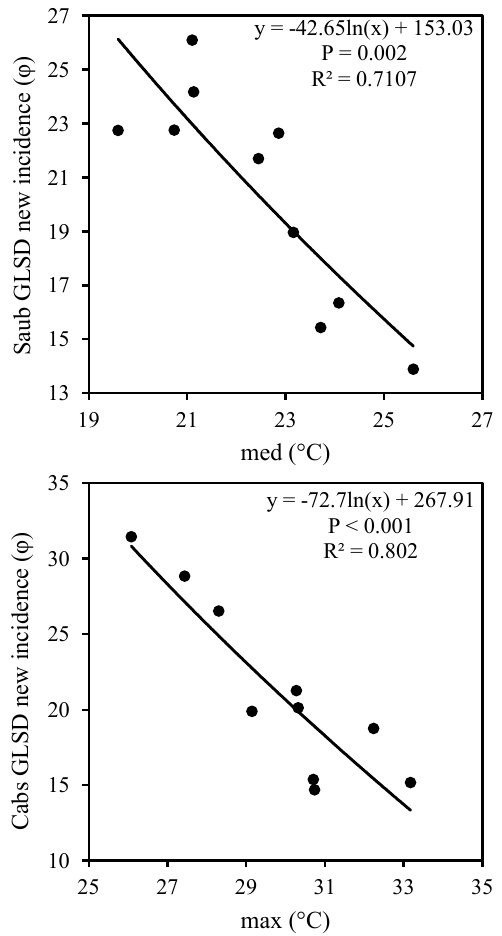
Figure 7. Regressions between arcsin-square root trans- formed (degrees ϕ) incidences of new Sauvignon blanc (Saub) and Cabernet sauvignon (Cabs) plants showing fo- liar symptoms in the second and third assessment and tem- perature parameters (med = average temperature; max = average maximum temperature) from the end of May to the end of